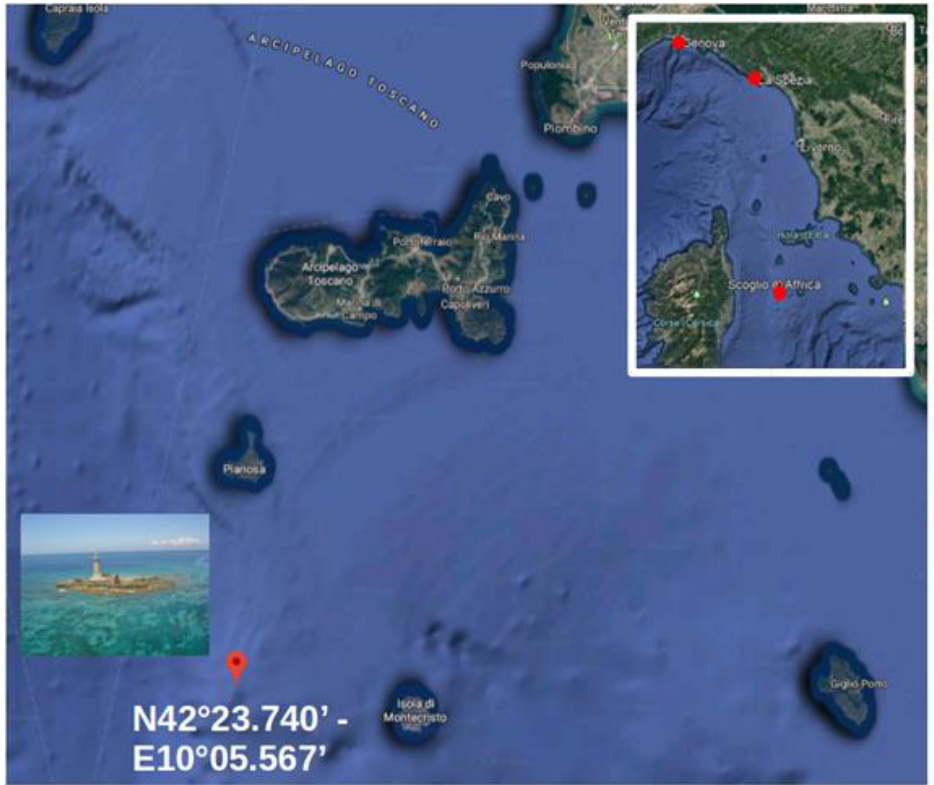
Figure 2. Map showing the location of the Scoglio d’Affrica (Tuscan archipelago) in the waters between the Tyrrhenian Sea and the Corsica Channel.